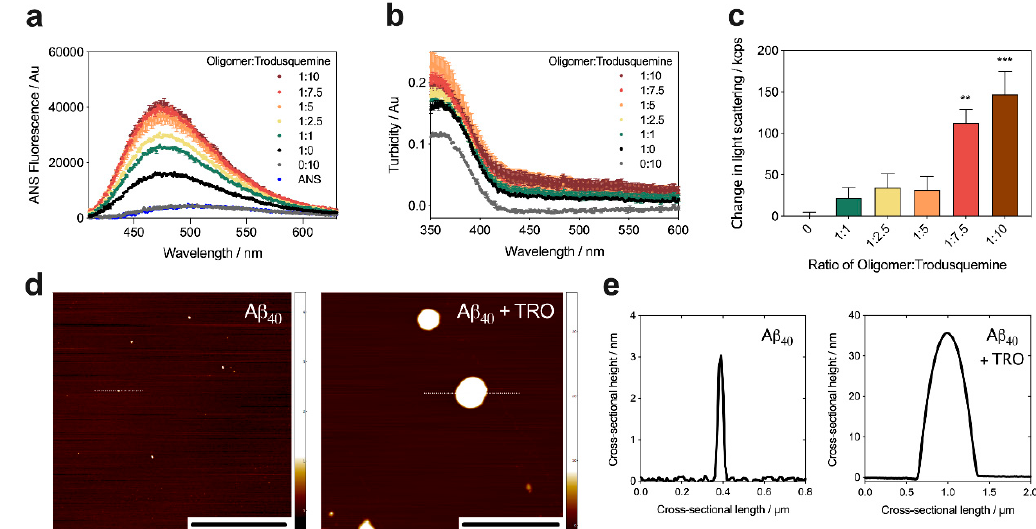
Figure 5. Trodusquemine increases the hydrophobicity and size of stabilized A β 40 oligomers. ( a,b ) Oligomers were incubated at a concentration of 5 µ M in the absence (black) and presence of 5 µ M (green), 12.5 µ M (yellow), 25 µ M (orange), 37.5 µ M (red), and 50 µ M (brown) trodusquemine and monitored for the binding of ANS ( a ) and turbidity absorbance ( b ). Grey traces indicate the e ff ect of 50 µ M trodusquemine (TRO) (i.e., the highest ratio tested) in the absence of oligomers. Error bars denote SEM of duplicate spectra. ( c ) SLS measurements after oligomer incubation in the presence of increasing concentrations of trodusquemine. Data are shown as the change in light scattered. Error bars represent the SEM of three replicates, and the symbols ** and *** indicate p < 0.01 and 0.001, respectively. Samples containing oligomers were analyzed by one-way ANOVA followed by Bonferroni’s multiple comparison test relative to oligomers in bu ff er. ( d ) AFM maps for oligomers incubated in the absence (left panel) or presence of a 5-fold excesses of trodusquemine (right panel). Scale bars, 2 µ m. Upper limits on the color scales are circa 4.2 nm for A β 40 oligomers alone (left panel) and 35 nm for the A β 40 oligomer-trodusquemine complex (right panel). ( e ) Representative cross-sectional heights of oligomers in the absence (left panel) and presence of trodusquemine (right panel). Dotted white lines in indicate the corresponding sampled cross section from ( d .